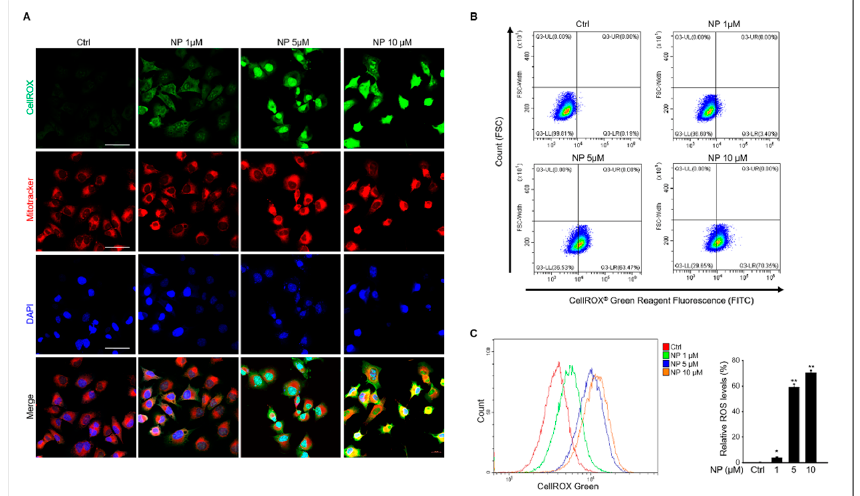
Figure 4. The effects of NP on mitochondrial reactive oxygen species production in GC-1 spg cells. ( A ) Treatment with 0, 1, 5, and 10 μ M NP. GC-1 spg cells were double-stained with CellROX and MitoTracker Red CMXRos to measure oxidative-stress levels. The green signal indicates oxidative stress, whereas the red signal indicates changes in mitochondrial membrane potential. All images were obtained at the same magnification and the scale bar = 50 μ m. ( B ) Flow cytometry plots for GC-1 spg cells stained with CellROX to measure oxidative stress levels. ( C ) Graphs represent the quantitative change of CellROX in NP-treated GC-1 spg cells. Data show the mean ± SD of three independent experiments ( n = 3, * p < 0.05 and ** p < 0.01 compared to the